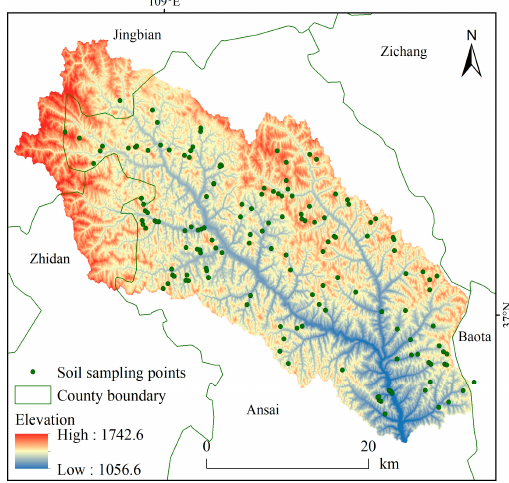
Figure 2. Soil sampling points in the Ansai Watershed.